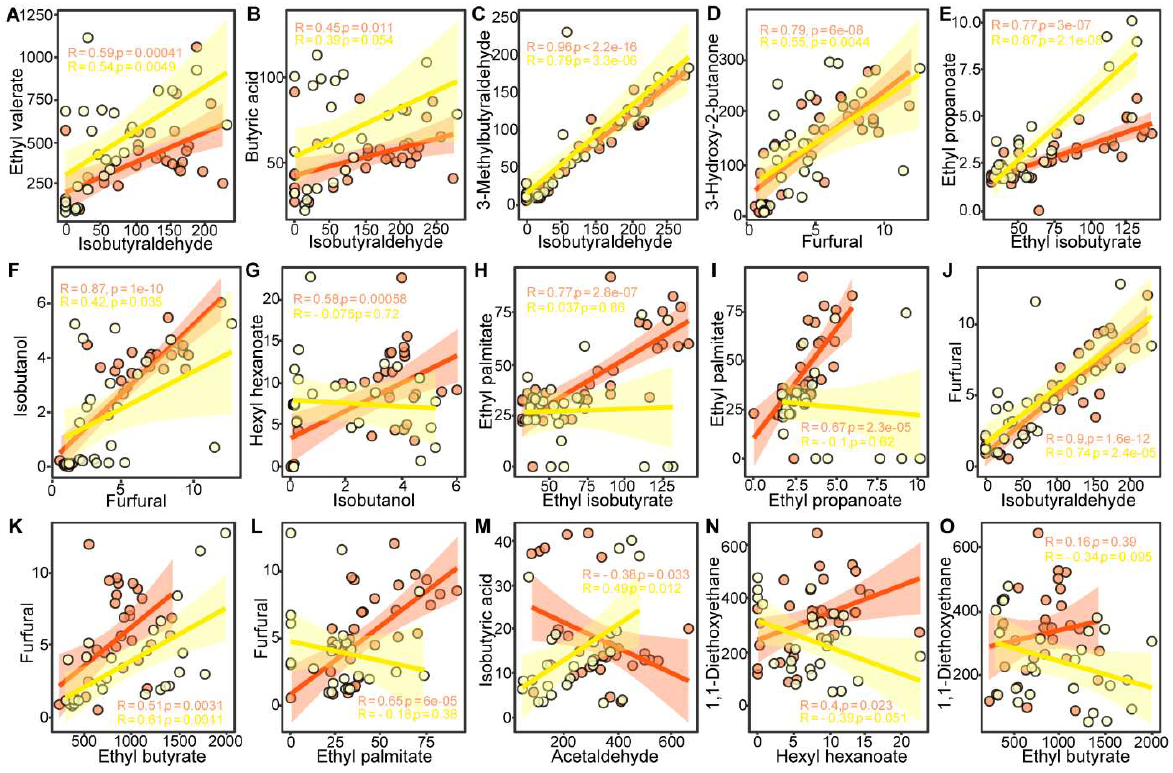
Figure 5. Correlations of key compound OAVs in the RG and the RP groups. ( A ) The correlation between isobutyraldehyde and ethyl valerate. ( B ) The correlation between isobutyraldehyde and butyric acid. ( C ) The correlation between isobutyraldehyde and 3-methylbutyraldehyde. ( D ) The correlation between furfural and 3-hydroxy-2-butanone. ( E ) The correlation between ethyl isobu- tyrate and ethyl propanoate. ( F ) The correlation between furfural and isobutanol. ( G ) The correla- tion between isobutanol and hexyl hexanoate. ( H ) The correlation between ethyl isobutyrate and ethyl palmitate. ( I ) The correlation between ethyl propanoate and ethyl palmitate. ( J ) The correlation between isobutyraldehyde and furfural. ( K ) The correlation between ethyl butyrate and furfural. ( L ) The correlation between ethyl palmitate and furfural. ( M ) The correlation between acetaldehyde and isobutyric acid. ( N ) The correlation between hexyl hexanoate and 1,1-diethoxyethane. ( O ) The correlation between ethyl butyrate and 1,1-diethoxyethane. The orange dots represent the OAV val- ues of a sample in the RG group, and the yellow dots represent the OAV values of a sample in the RP group. The orange lines with light orange backgrounds represent the trend lines and standard deviations of OAV values in the RG group and the yellow lines with canary backgrounds represent the trend lines and standard deviations of OAV values in the RP group The R values represent correlation coefficient values, and the p values represent the significance of the correlations. 4. Conclusions In this study, the authors quantified 64 aroma compounds in 66 SAB samples using a GC-FID platform; samples were grouped into two quality groups based on their sensory evaluation result. The authors used aroma compound correlations and OAV ratio-based classification to illustrate the odor balance differentiations between the RG and the RP groups. The results showed the OAV-based random forest classification and the OAV ra- tio-based random forest classification had the same accuracy but different precision. Ac- cording to the OAV ratio-based random forest classification and compound correlations in the two quality groups of SABs, the balance of fruity-like ethyl valerate, green- and malt-like isobutyraldehyde, and malt-like 3-methylbutyraldehyde and sweet-like furfural might be one of the most important aroma compound balances sets in SAB. Though this study illustrated a new insight into aroma compound correlation, future studies are needed to illustrate the mechanism of aroma compound interactions and assess the impact of compound balance via sensory tests. The classifier established here using the